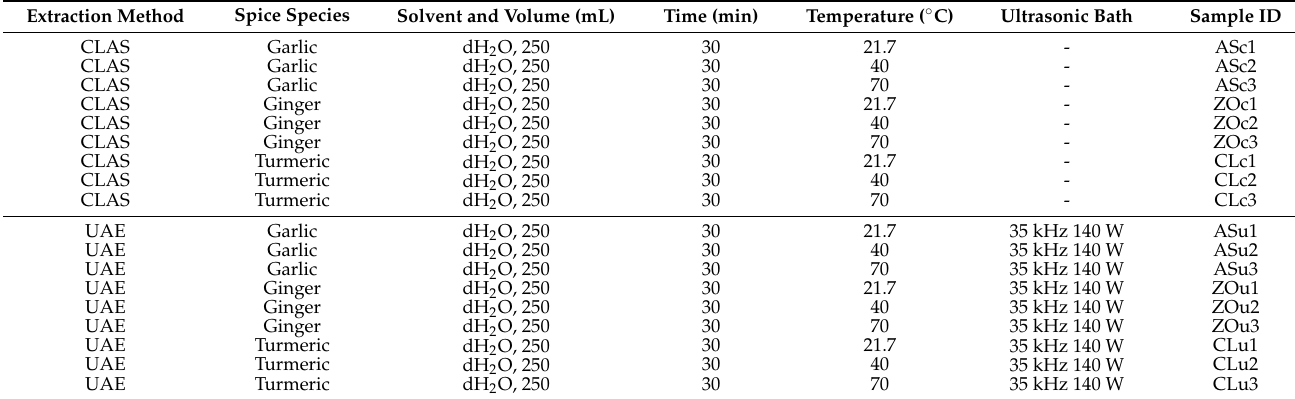
Table 5. Experimental conditions of classic (CLAS) and ultrasound-assisted extraction